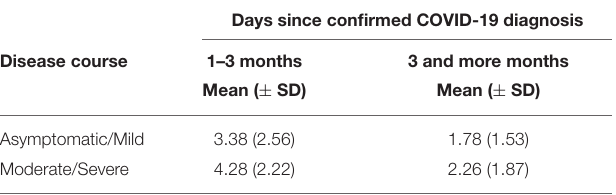
TABLE 4 | Mean antibody ratio since confirmed COVID-19 diagnosis and disease